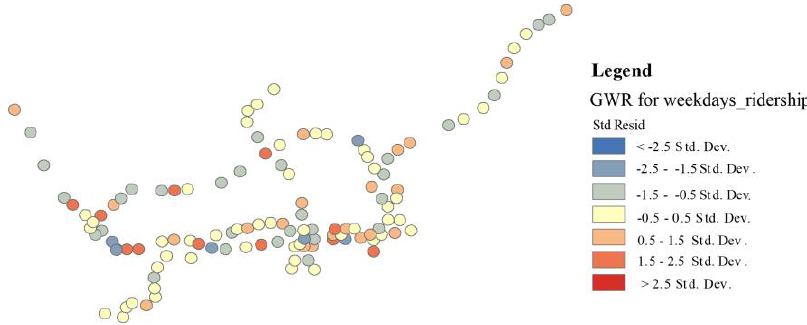
Figure 4. Standardized residuals of GWR for average weekday ridership (Model 2). Table 6. Global Mora n’s I residuals test of the models for the average ridership across the whole week.